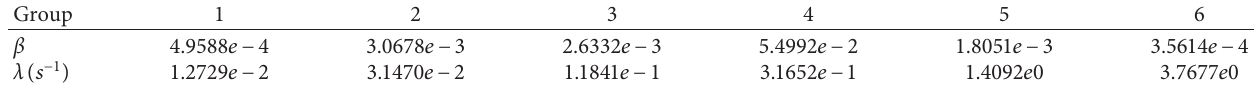
Table 6: Six sets of delayed neutron precursor parameters.